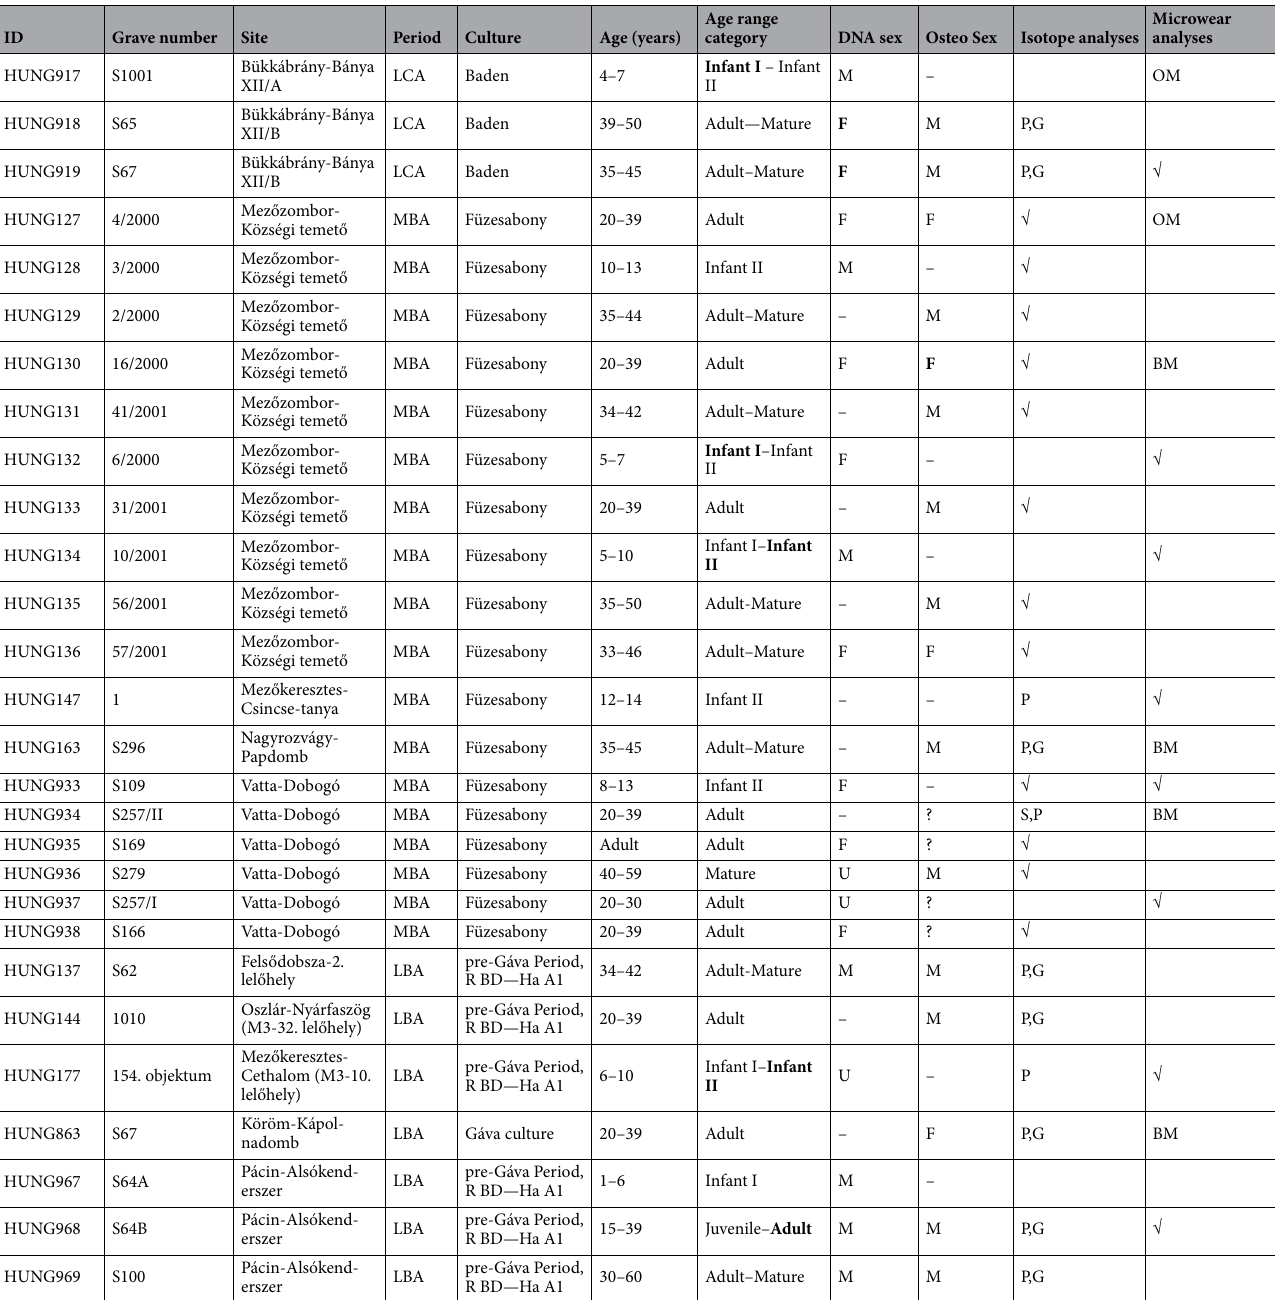
Table 2. List of individuals employed in this study. Details of the site, period, culture and biological (age, sex) information, and the statistical analyses included. Age range category: Infant I (1–6 years), Infant II (7–14 years), Juvenile (15–19 years), Adult (20–39), and Mature (40–59); in bold the age category used for statistical analyses when the sample age (years) range include two age categories a . Isotope data was included for period (P), site (S), gender (G) and/or all (√) statistical comparisons. Microwear analyses were performed in buccal (BM), occlusal (OM) or both (√) enamel surfaces. Period abbreviations: Middle Neolithic (MN), Late Neolithic (LN), Middle Copper Age (MCA), Late Copper Age (LCA), Middle Bronze Age (MBA), Late Bronze Age (LBA); Sex abbreviations: female (F), male (M), undetermined (U), not possible to assign (?). a The age category selected was chosen according to the higher number of years of the age range estimation belonging to each category. When age cohort is between Adult and Mature category, no choice was made as both categories were included together as adult in the statistical